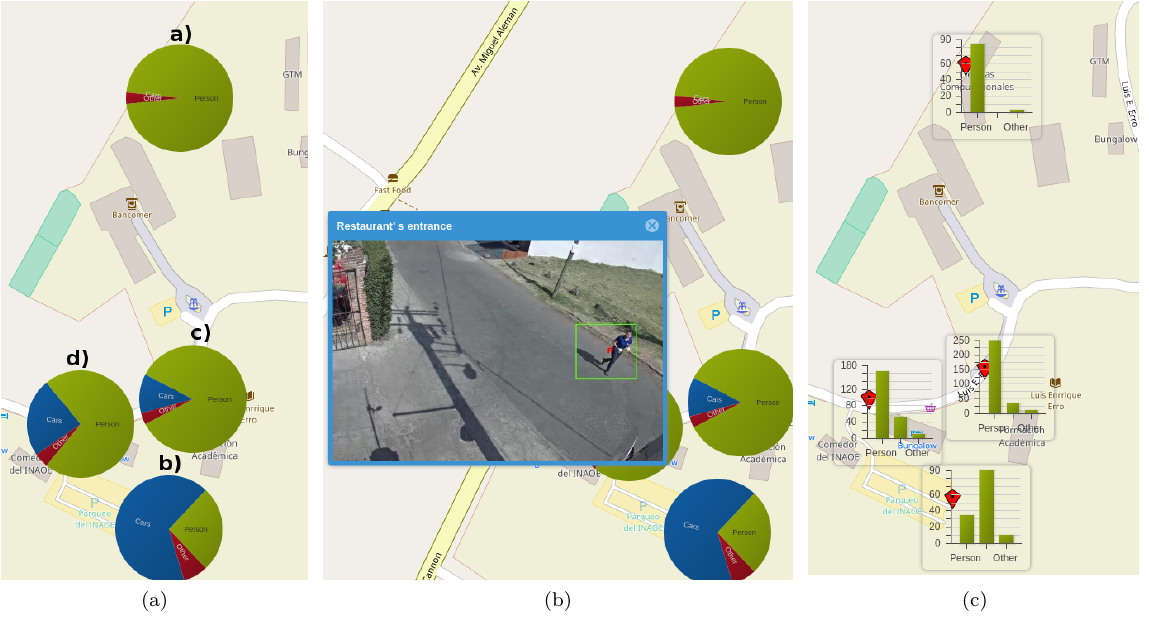
Figure 5. Resulting visualization of the number of persons (green), vehicles (blue), and others (red) detected by each camera during two hours (see queries 1, 2, and 3). Left figure shows a Pie-chart visualization. Center figure shows a Pie-chart visualization and real time video rendering of camera d). Right figure depicts a Bar-chart visualization. In this figure is shown that camera a) does not recognize vehicles because it is in an indoor scenario. Cameras c) and